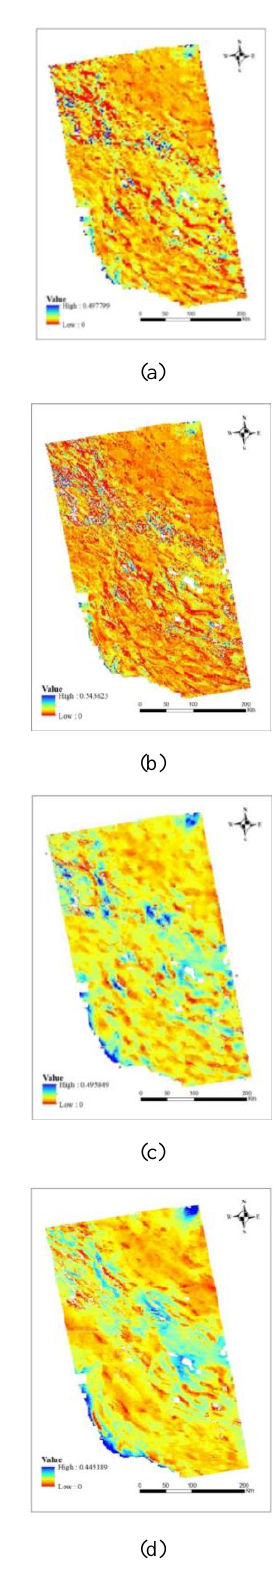
Figure 3 . (a) 3 km SMAP soil moisture product, (b) 1 km SMAP soil moisture product which has been already downscaled using Sentinel-1, (c) 1 km SMAP soil moisture product downscaled using regression method and (d) 1 km SMAP soil moisture product downscaled using neural